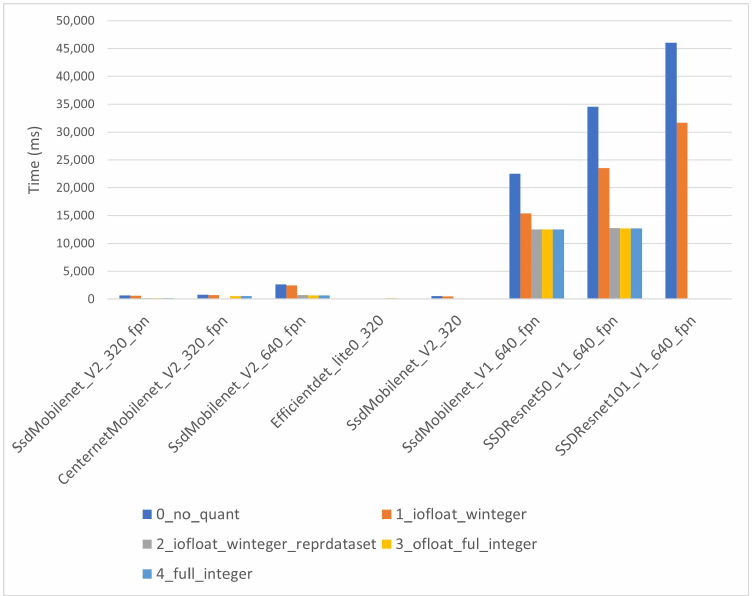
Figure 14. EdgeTPU warm up times for large models.